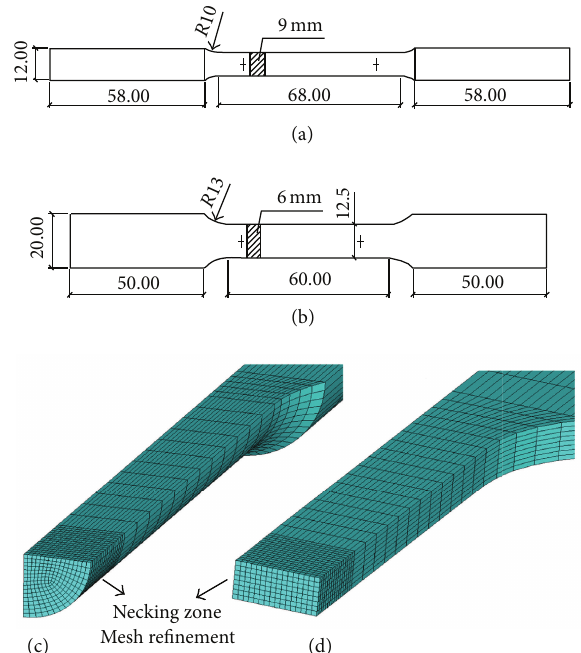
Figure 4: Geometric configurations for (a) cylindrical and (b) rectangular samples and finite element mesh for (c) cylindrical and (d) rectangular specimens.